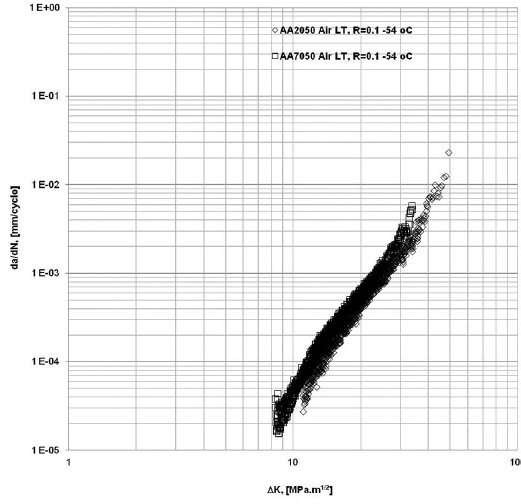
Figure 5. da/dN x ΔK curves for the AA2050-T84 Al-Li and AA7050-T7451 Al alloys tested in air, R = 0.1, 15Hz frequency at –54 °C.